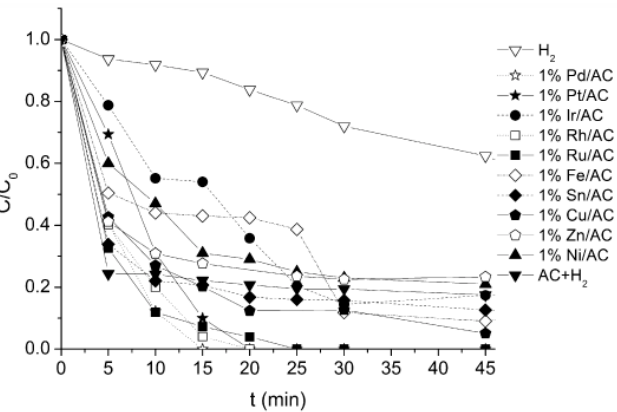
Figure 2. Dimensionless concentration of bromate during catalytic reduction experiments using hydrogen in the presence of monometallic catalysts supported on activated carbon (AC). Reprinted from [64], Copyright (2015), with permission from Elsevier.